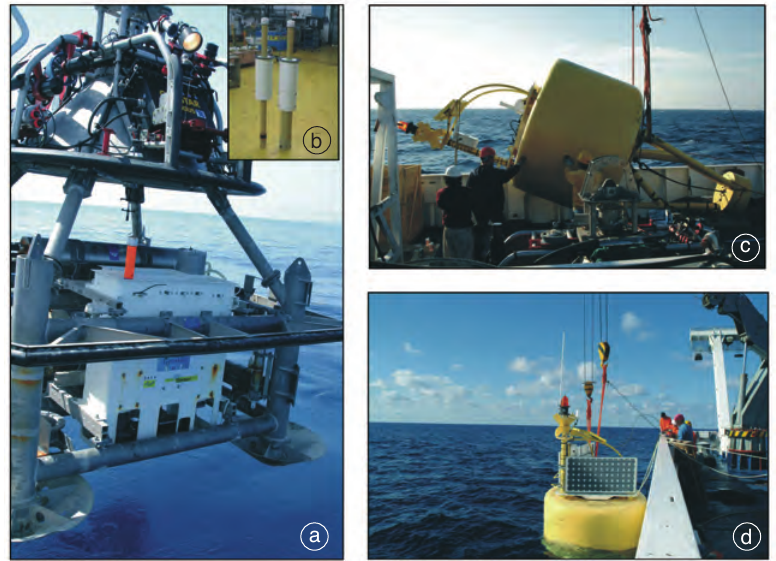
Fig. 5a-d. a) M ESSENGERS installed on the Bottom Station (height 1.3 m); b) M ESSENGERS Storage and Expend- able-type in Brest IFREMER Laboratory; c) surface buoy (weight: 35 kN; volume: 5 m 3 ) GEOSTAR-2 version on board R/V Urania; d) surface buoy ORION-GEOSTAR-3 version just